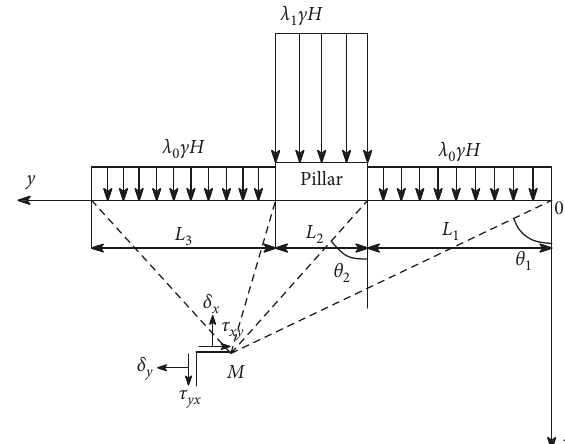
Figure 2: Load transfer model of the boundary coal